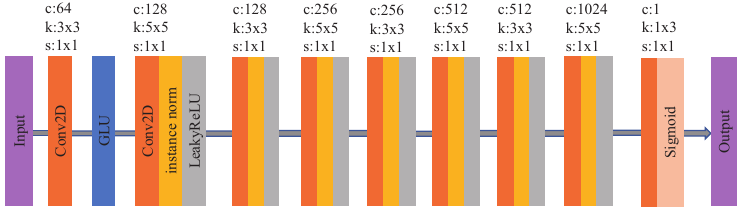
Figure 4. Discriminator structure of the BSEGAN-SI